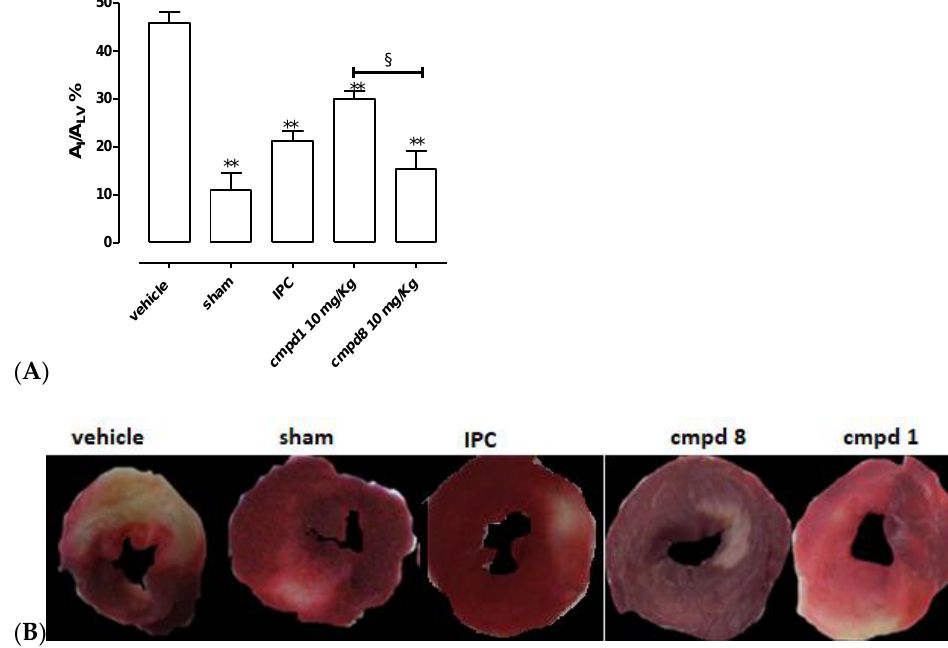
Figure 5. ( A ) The histograms show the extent of the ischemic area (A I ) compared with the total area of the left ventricle (A LV ) in the different groups. Data are expressed as mean ± SEM. *indicates significant difference vs. vehicle (** p < 0.01). § indicates significant difference vs. compound 1 (resveratrol) group (§ p < 0.05). Number of animals used = 5. ( B ) Exemplificative pictures of several types of